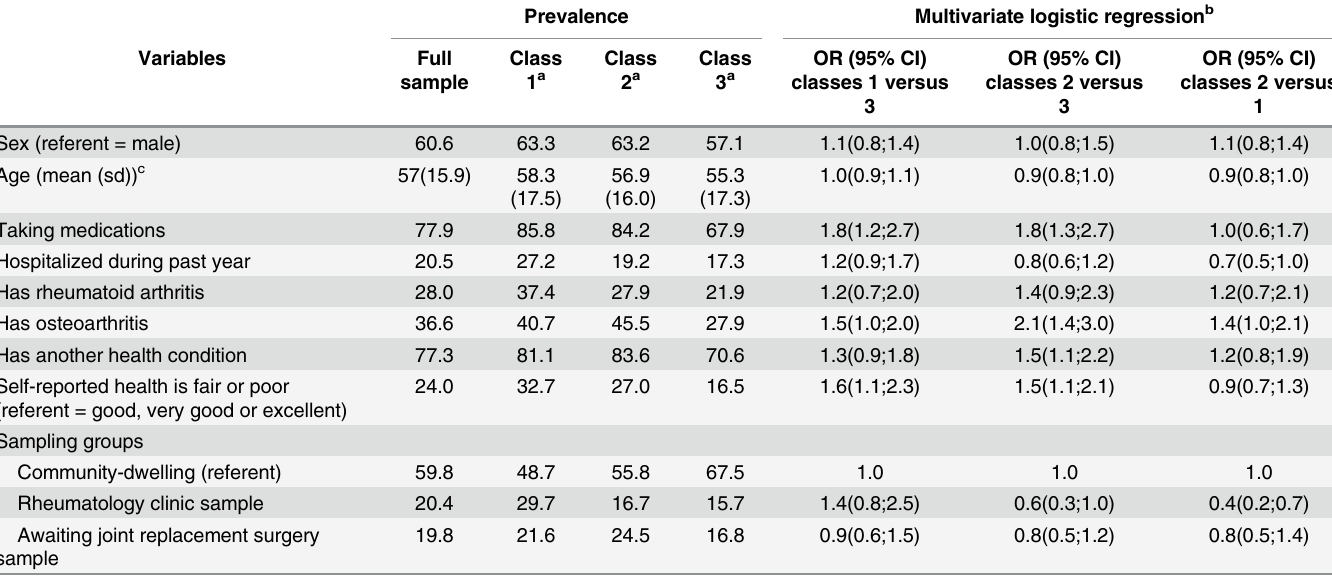
Table 1. Description of the Sample and Latent